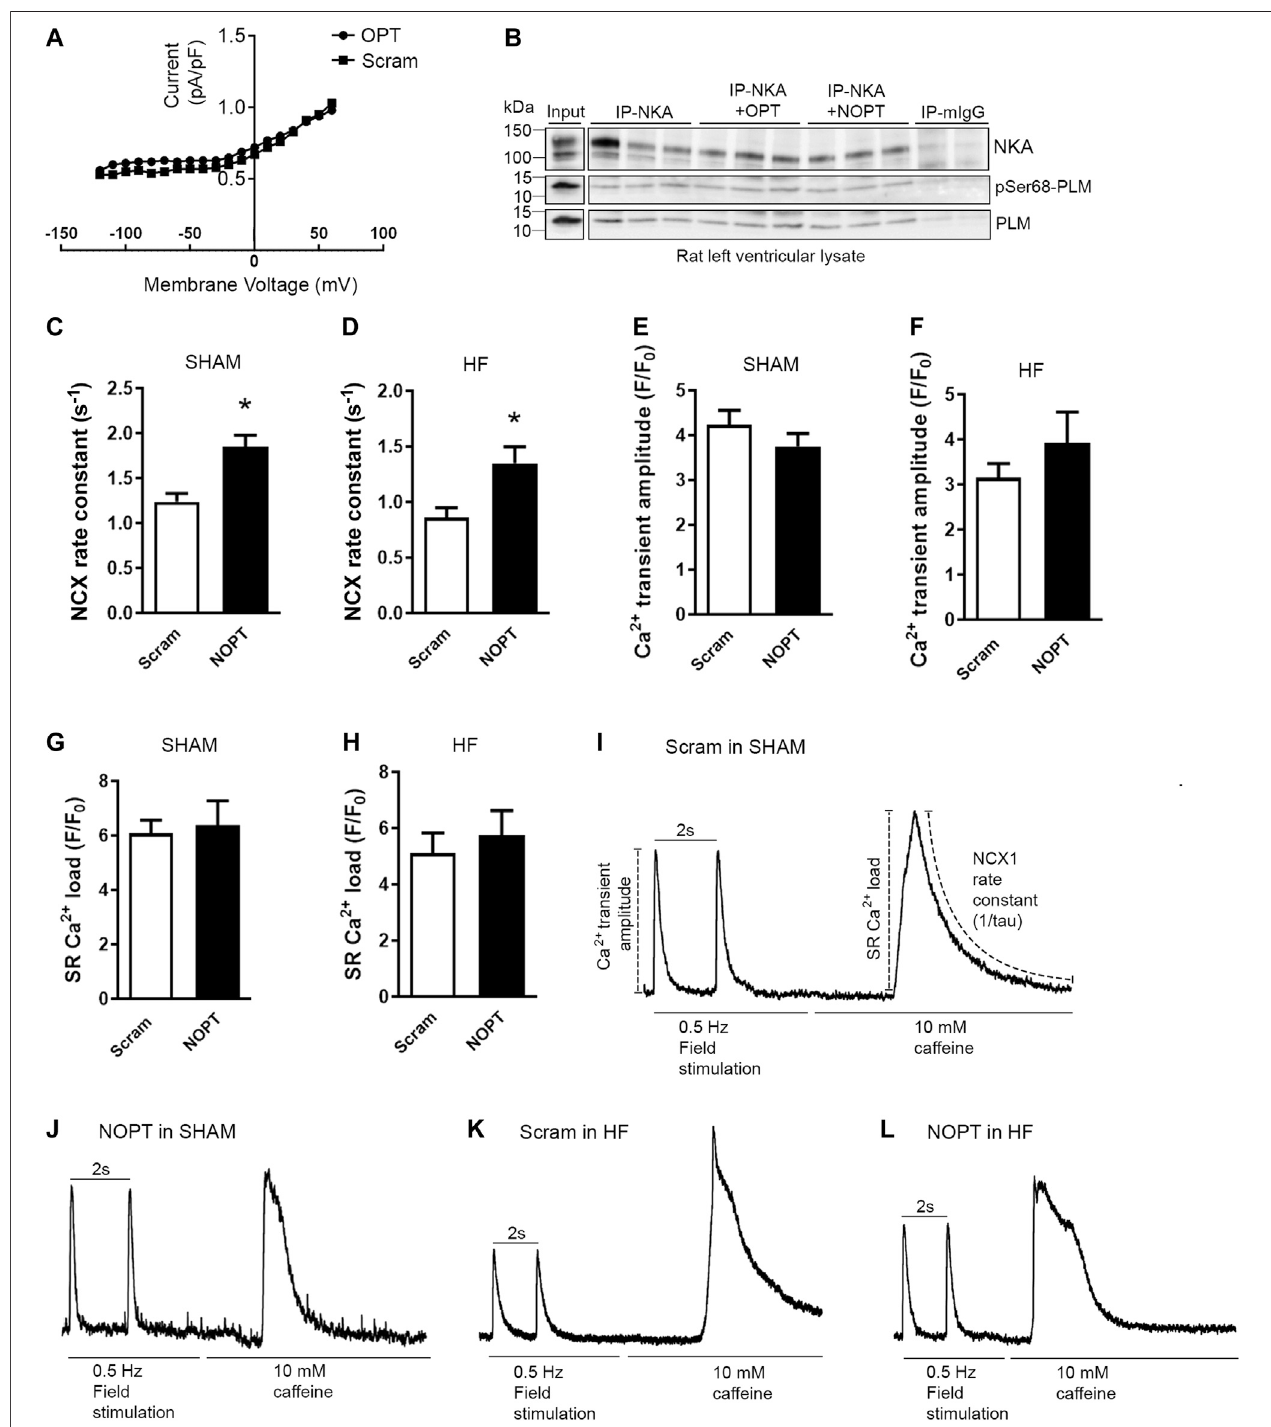
FIGURE 4 | NOPT increases NCX-mediated Ca 2+ extrusion in cardiomyocytes isolated from SHAM-operated and aorta banded HF mice. (A) No effect of the 20- mer original OPT peptide (Wanichawan et al., 2016) on NKA current was con fi rmed in adult rat cardiomyocytes. A scrambled control peptide was used as control ( n (cid:2) 6 cells from three rats). (B) Immunoprecipitation of NKA-PLM/pSer68-PLM from rat left ventricle lysate with or without in presence of OPT or NOPT (100 μ M). The precipitates were analyzed byimmunoblottingwith speci fi cantibodies against NKA, PLM and pSer68-PLM. Nonrelevantmouse IgG (mIgG)wasused asnegative control ( n (cid:2) 3). Average NCX rate constant measured in fi eld stimulated (C) SHAM and (D) HF cardiomyocytes that were treated with NOPT-TAT or ascrambled control peptide. Average Ca 2+ transient amplitude measured in fi eld-stimulated (E) SHAM and (F) HF cardiomyocytes that were treated with NOPT-TAT or a scrambled